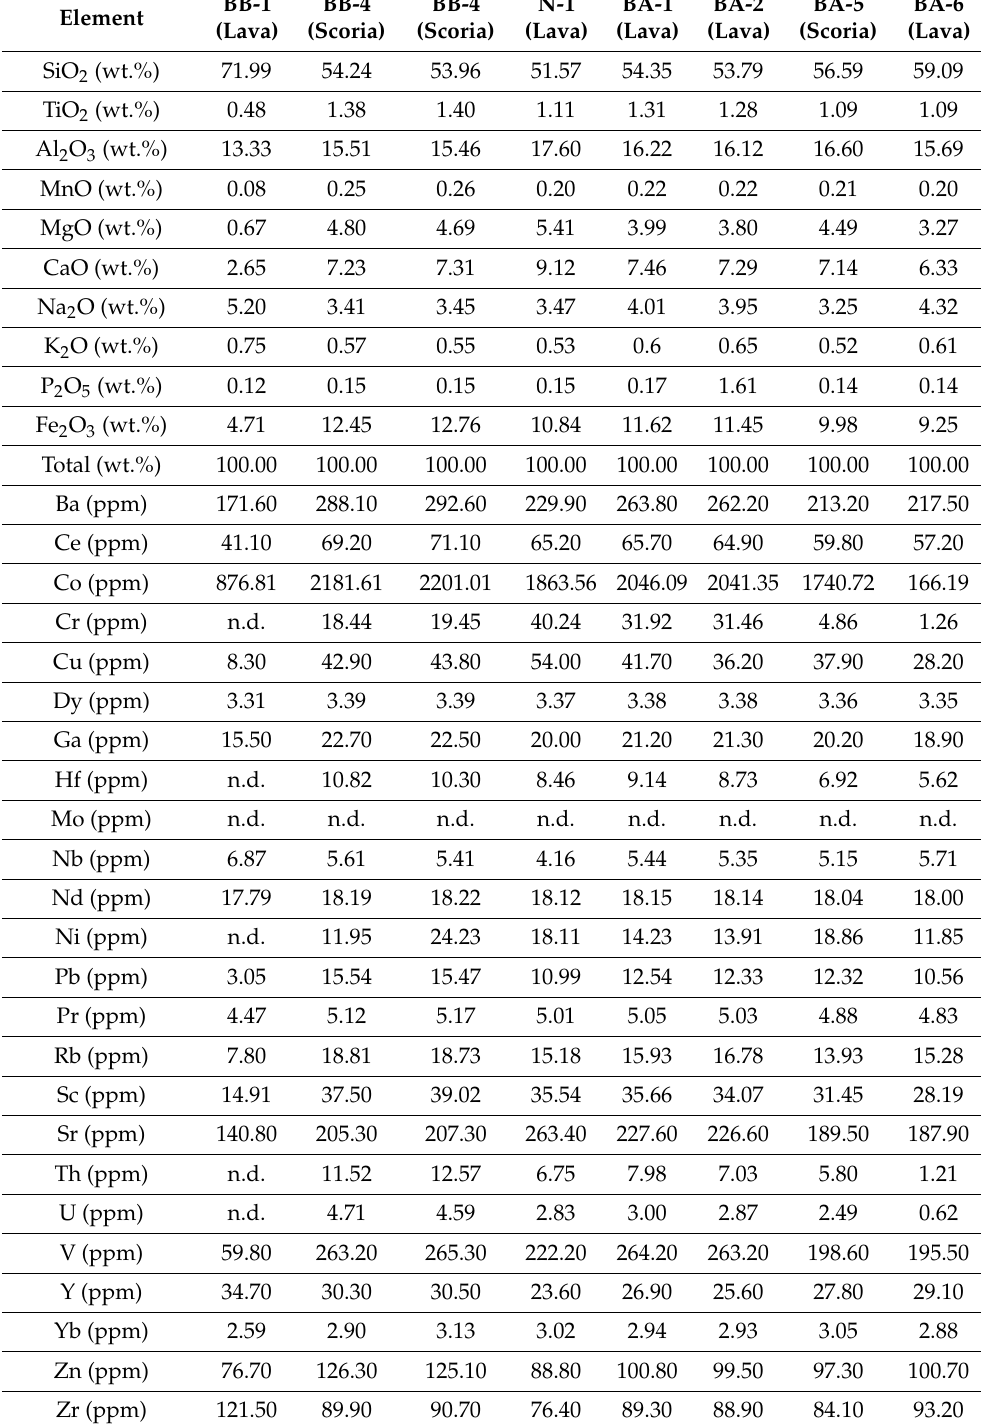
Table 4. Bulk-rock geochemistry of the BVC scoria (S) and lava (L). All samples have been normalized to 100%